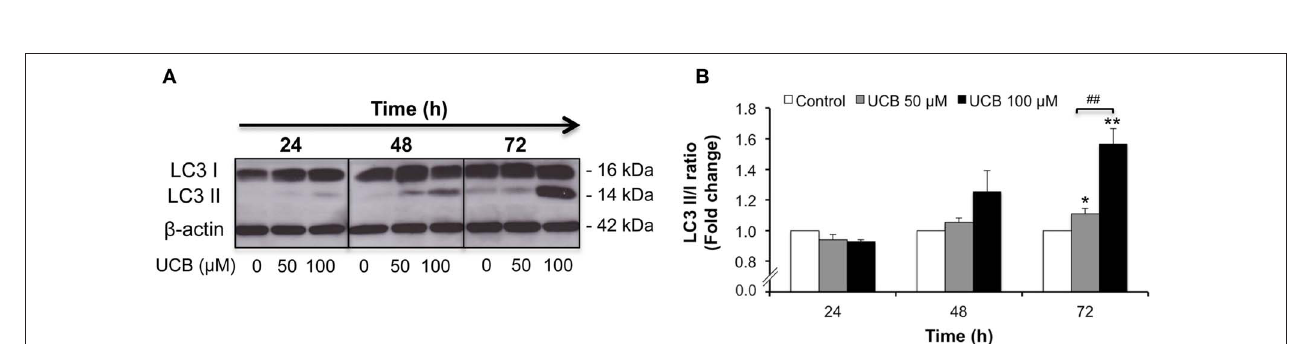
FIGURE 7 | Prolonged interaction of UCB with the HBMEC monolayer activates autophagy. HBMEC line was incubated without (control) or with 50 or 100 μ M UCB, in the presence of 100 μ M HSA, for the indicated periods. Autophagy was evaluated by Western blot, with LC3 I (free form) and II (phosphatidylethanolamine-conjugated form) detection. Representative results of one experiment are shown (A) . Quantification of